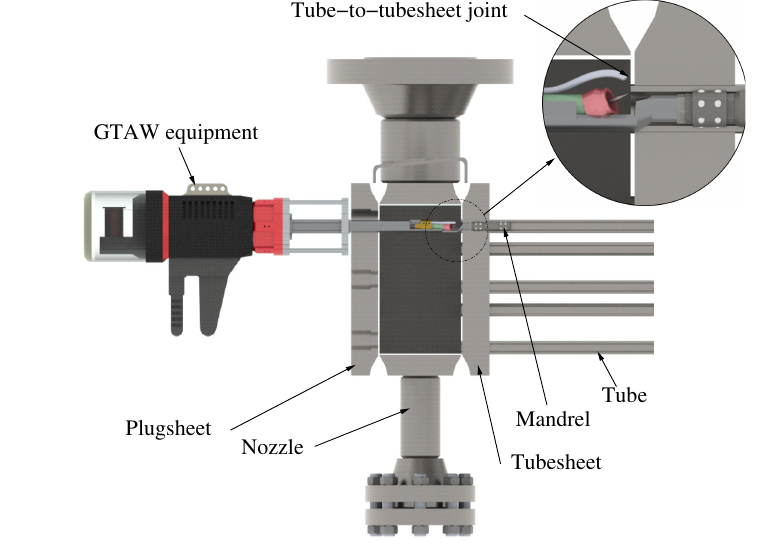
Figure 4. Detail of how orbital GTAW equipment accesses the tube-to-tubesheet joint to carry out the